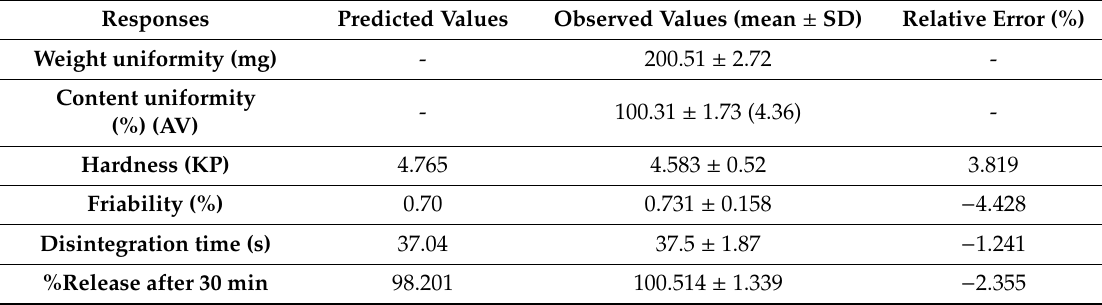
Table 4. Predicted and actual values for all dependent responses of optimized formulation with their relative